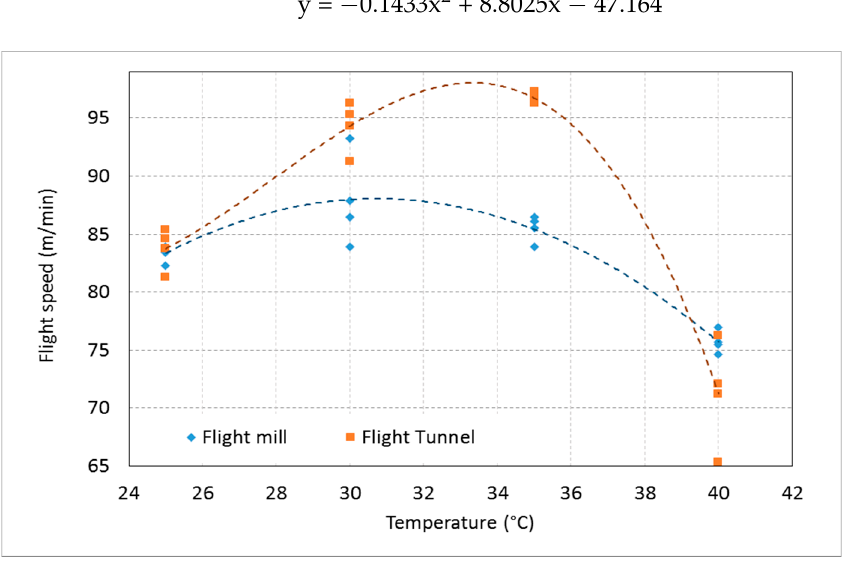
Figure 24. Effect of temperature on flight speed of RPW at RH of 35% using the computerized flight mill and the flight tunnel.